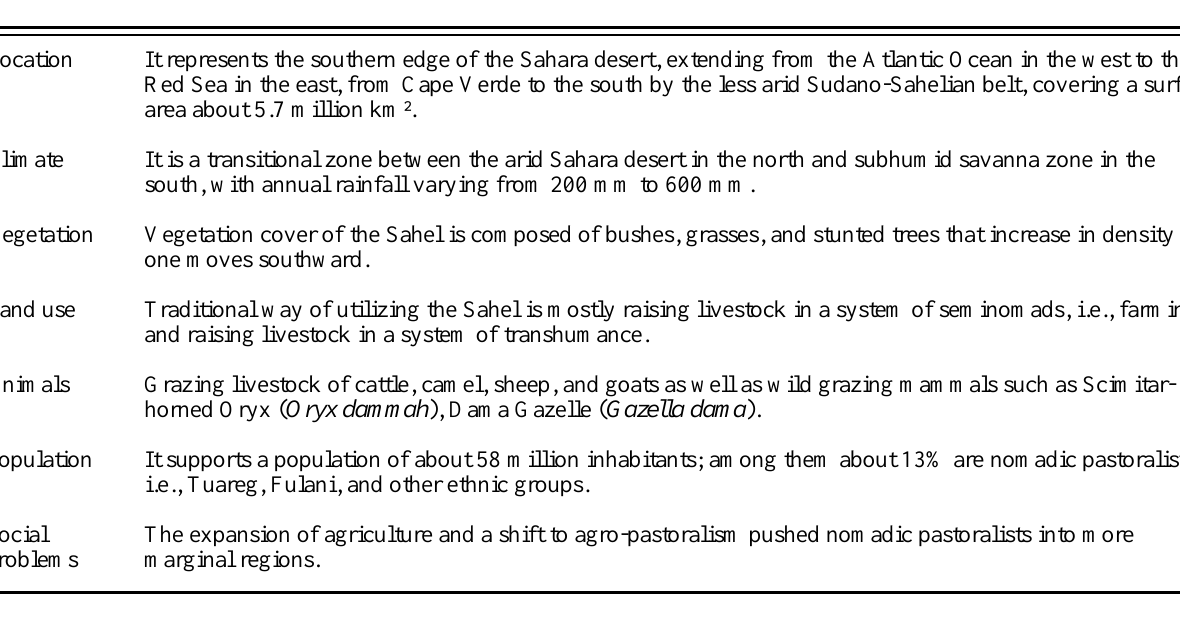
Table 1. General information on the African Sahel (Kandji et al. 2006).